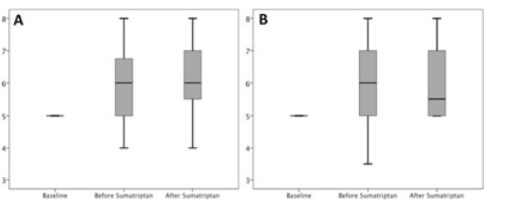
Fig 6. Pain score: Boxplot of pain scores (NRS) after noxious heat stimulation at baseline, before sumatriptan and after sumatriptan administration. A (left side) show the pain scores on the CGRP days. B (Right side) show the pain scores on the placebo day. There was no difference in pain score between the two experimental days at baseline ( P = 1 . 0 ), before sumatriptan ( P = 0 . 87 ) and after sumatriptan ( P = 0 . 36 )